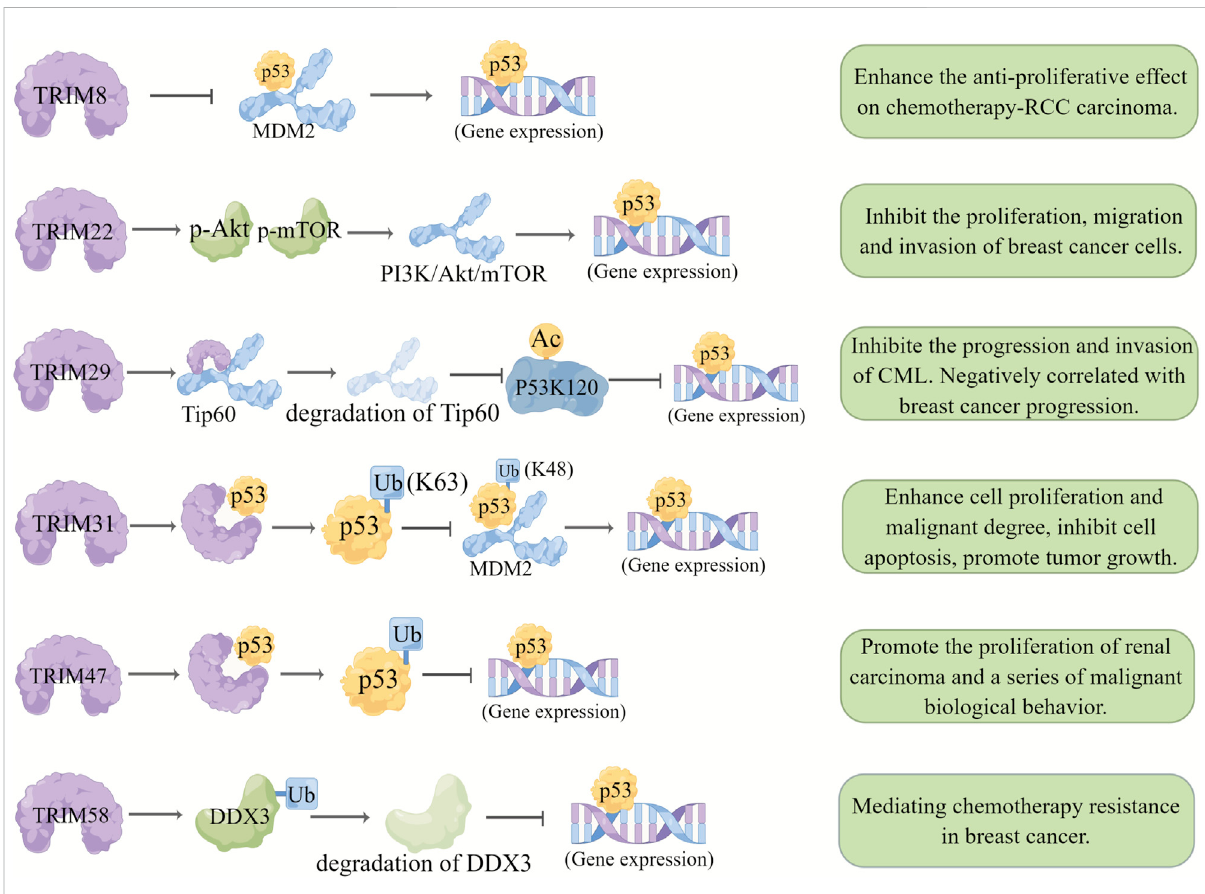
FIGURE 3 Relationship between TRIMs and p53. TRIM proteins regulate the p53 pathway by affecting different target genes and play different roles in different cancers. Degradation of a target gene is represented by a lighter color of the same pattern.TRIM8 inhibited the binding of p53 and MDM2 and stabilized the expression of p53. TRIM22 promotes the activation of the PI3K/AKT/mTOR pathway and the expression of p53 by promotingthelevelsofp-Aktandp-mTOR.TRIM29interactswiththeacetyltransferaseTIP60topromotethedegradationofTIP60andreduce TIP60-mediated acetylation of p53K120. TRIM31 directly interacts with p53 to induce K63 ubiquitination of p53 and inhibits MDM2-mediated K48 ubiquitination through competitive inhibition of the interaction between MDM2 and p53, leading to the stabilization and activation of p53. The interaction between TRIM47 and the p53 protein increases the ubiquitination of p53resulting in its degradation. TRIM58 interacts with DDX3, resulting in ubiquitination and degradation of DDX3 and inhibition of p53